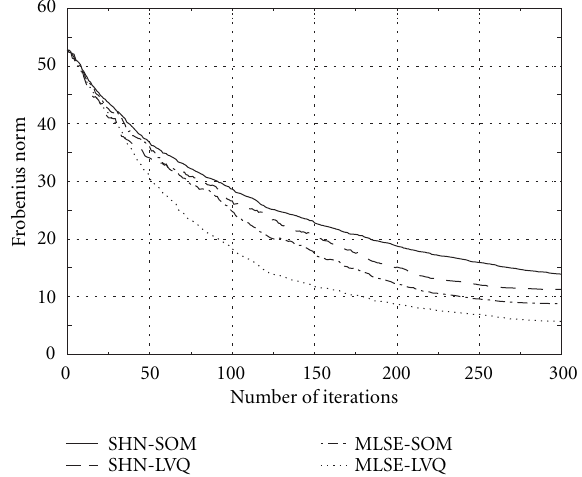
Figure 7: The synchronous case: Frobenius norm versus number of